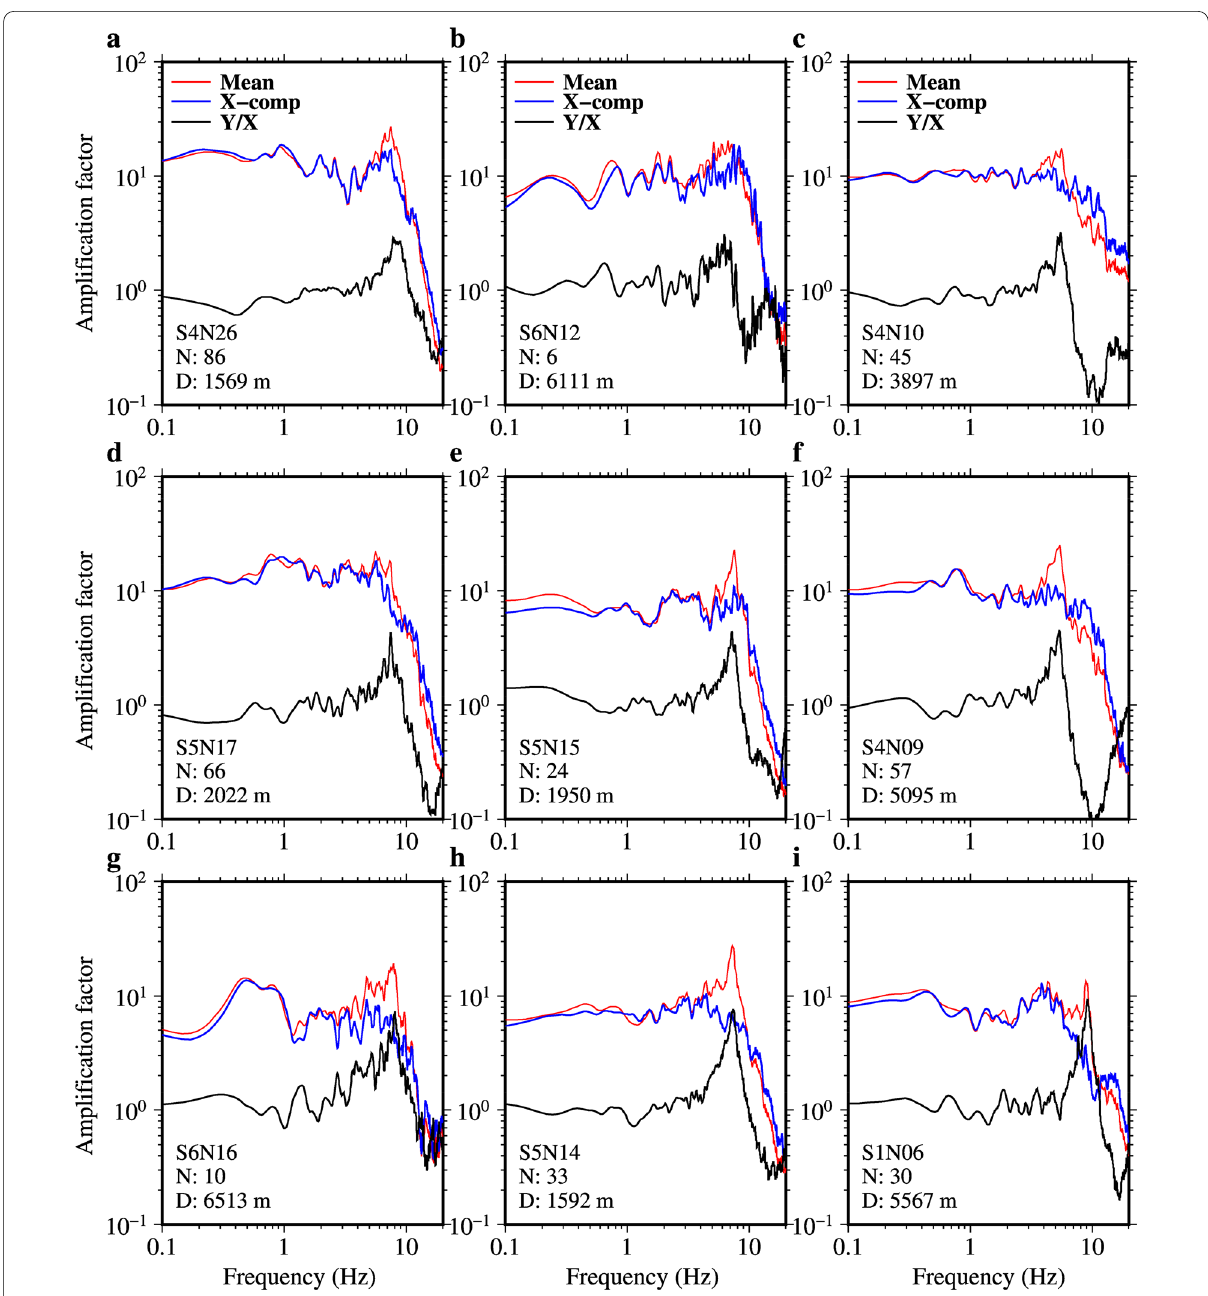
Fig. 13 Example comparison of the site spectra obtained from the spectral inversions of mean spectra of X- and Y-component records (red lines) and spectra of X-component records (blue lines) at sites, where the spurious site spectra were recognized. The plots a , b , c , d , e , f , g , h , and i correspond to sites, namely, S4N26, S6N12, S4N10, S5N17, S5N15, S4N09, S6N16, S5N14, and S1N06, as indicated in each panel. See Fig. 11 for the location of the sites. The black lines denote the mean spectral ratios between the horizontal Y- and X-component records. The number of earthquake records (N) used for each site and the depth to the seafloor (D) are indicated in each